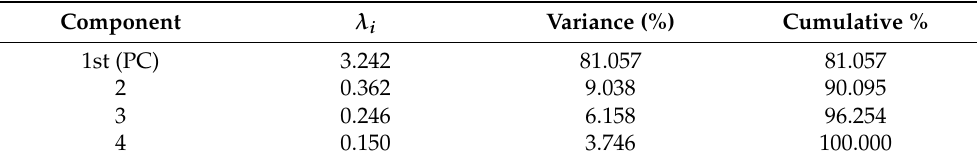
Table 3. Eigenvalues and weight of principal components in PCA analysis.